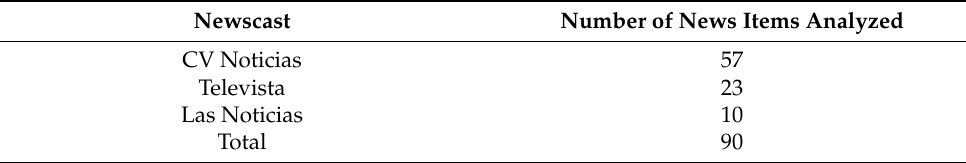
Table 3. Number of news items per newscast (Source: